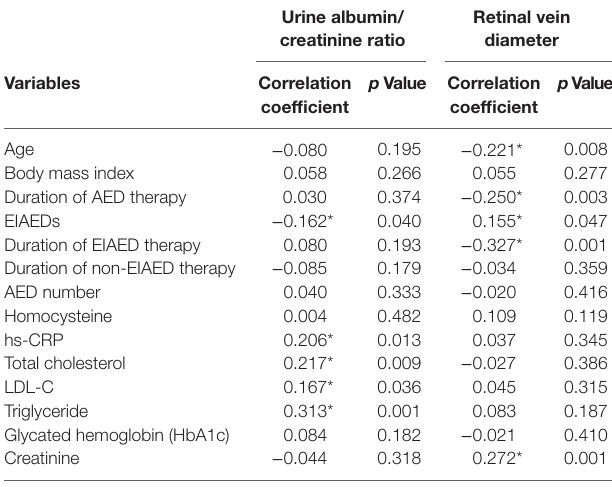
AED, antiepileptic drug, EIAEDs, enzyme-inducing antiepileptic drugs, hs-CRP, high- sensitivity C-reactive protein; LDL-C, low-density lipoprotein cholesterol; BMI, body mass index. The duration of AED therapy was considered 0 in the control group.